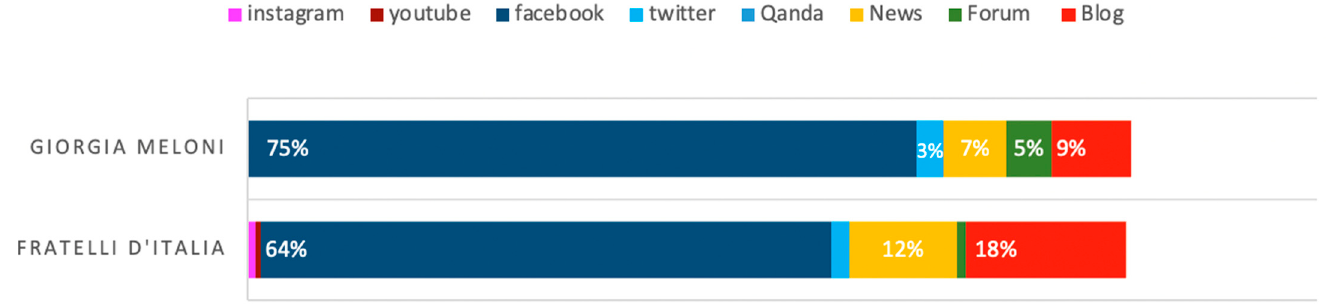
Figure 5. Polls retrieved by Swg, February 2021.